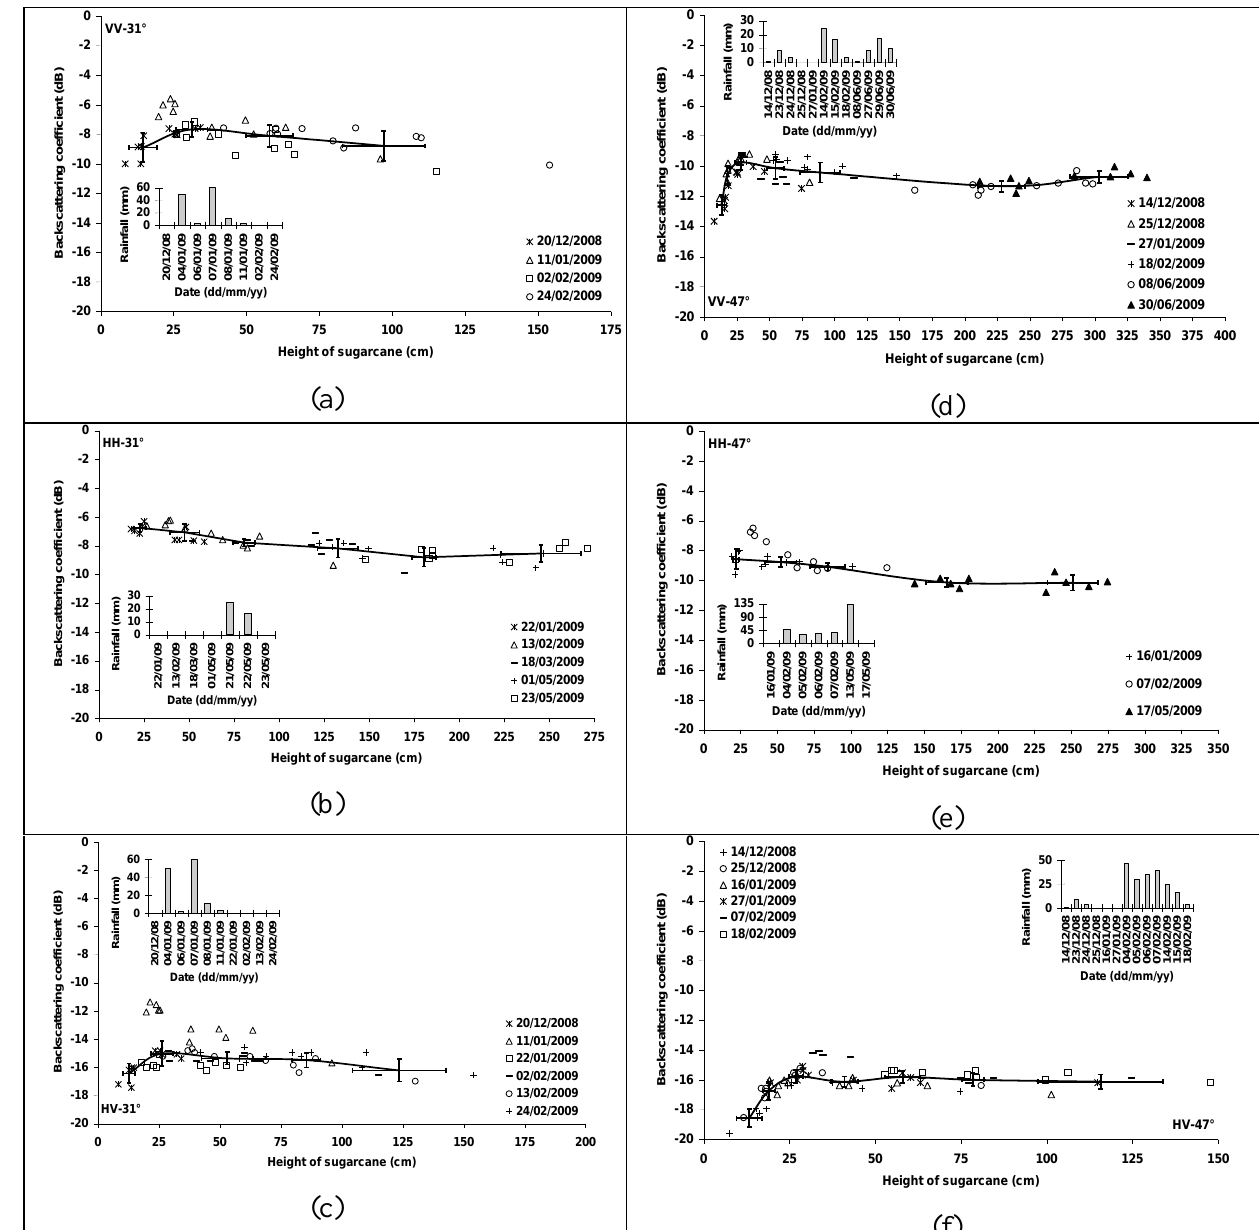
Figure 3. Radar backscattering coefficient as a function of plant height for VV, HH, and HV polarizations and incidence angle of 31° and 47°. The sugarcane height corresponds to the height of terminal visible dewlap (htvd). Bars represent standard deviation of the